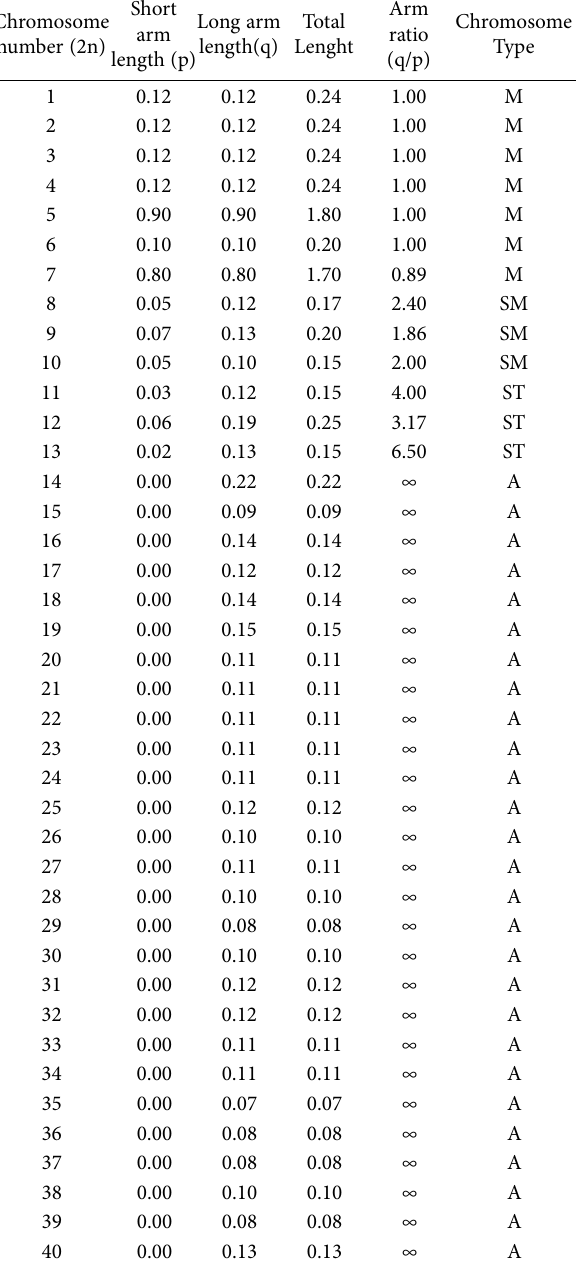
Table 2. Relative arm lenght (µ), total lenght (µ), arm ratio (p/q) and chromosome type of Abant trout.